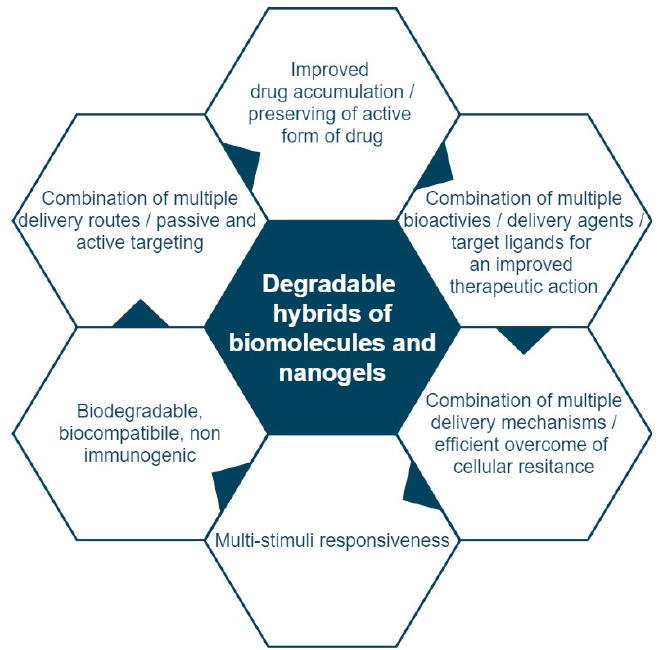
Figure 1. Major advantages of application of degradable hybrids of biomolecules and nanogels (NGs) as controlled drug-release and targeted delivery